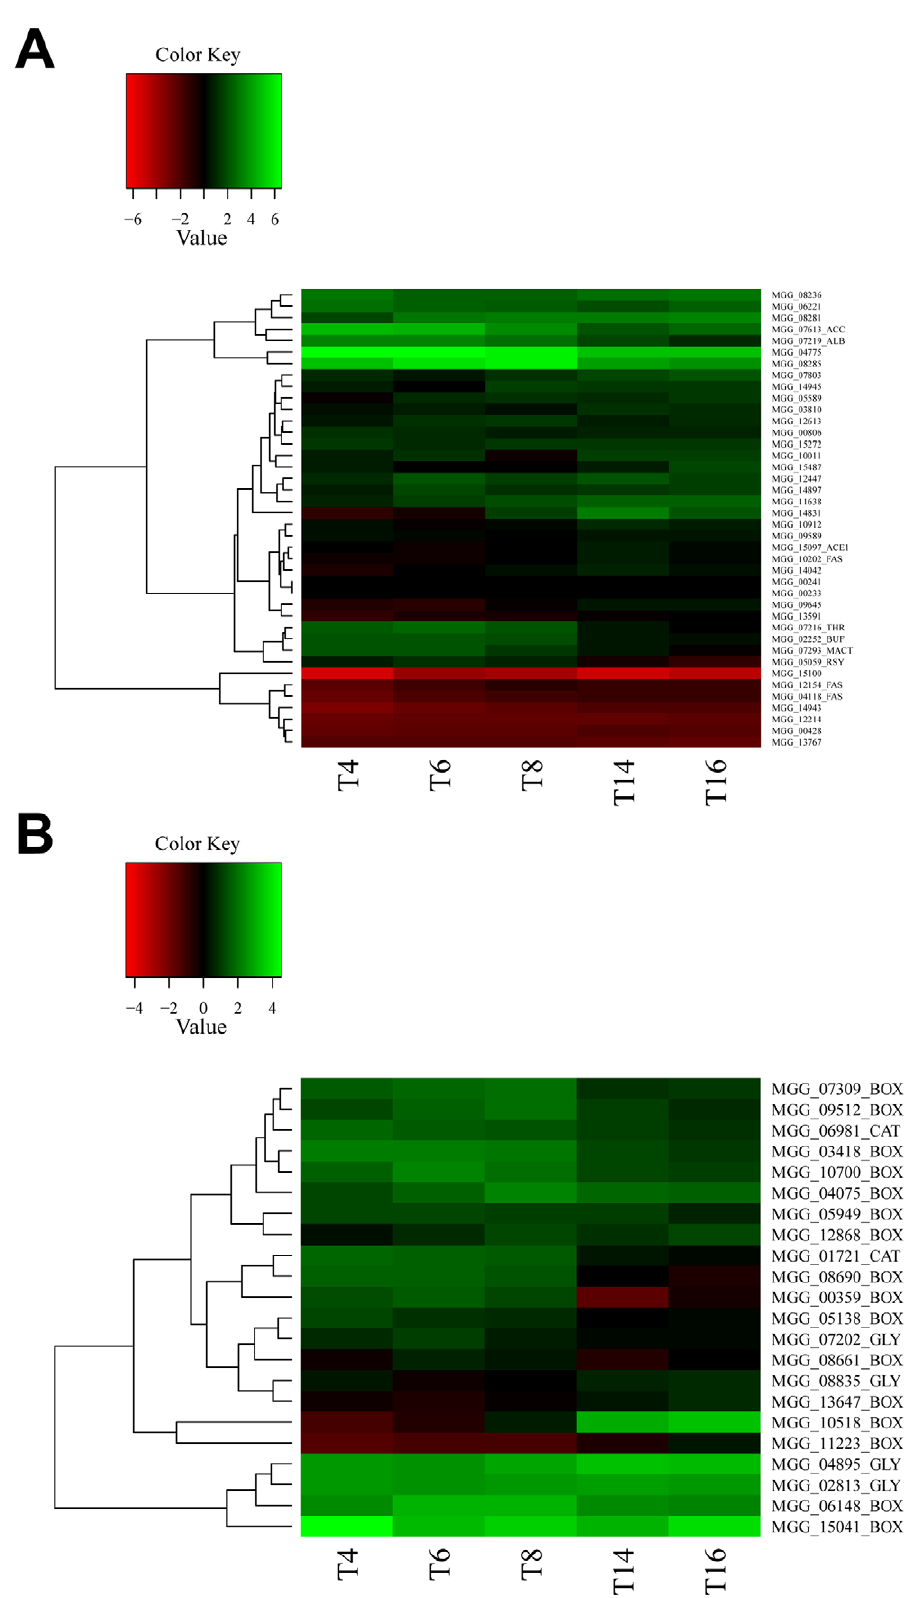
Figure 3. Heatmaps showing levels of transcript abundance during time course of appressorium development. Levels of expression are represented as moderated log 2 ratio of transcript abundance compared to mycelium grown in complete medium. Values are from 4 h (T4) to 16 h (T16) after conidia were placed on a hydrophobic surface. Genes showing similar patterns of gene expression are clustered. A . Genes encoding